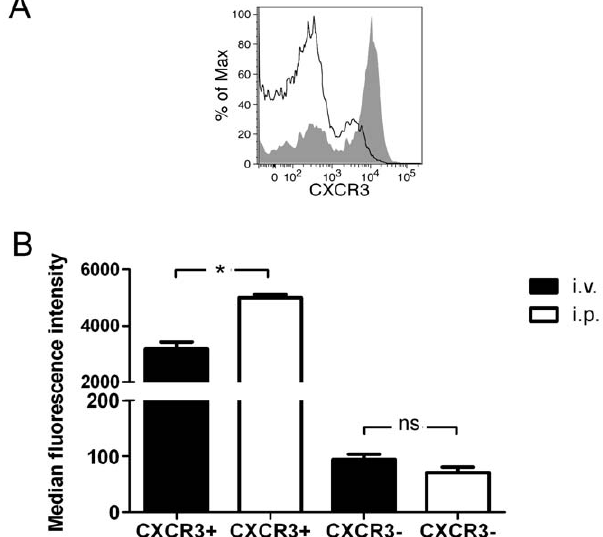
Figure 3. The PerC environment results in increased expression of CXCR3 on CD4 + T cells. (A) The expression level of CXCR3 on CD4 + cells from spleen (black line) or PerC (grey area) of BALB/c mice was determined by flow cytometry. (B) CXCR3 + and CXCR3 2 CD4 + T cells were sorted from Sp of donor BALB/c mice and stained with CFSE. Cells were then adoptively transferred to naı¨ve recipient animals by i.v or i.p. route. After 24 h, cells were re-isolated from spleens or peritoneal cavities and re-stained with an anti-CXCR3 antibody. The expression level of CXCR3 on CFSE + cells was then analyzed by flow cytometry. The differences were statistically significant at P , 0.001 (*), n.s. – not significant.